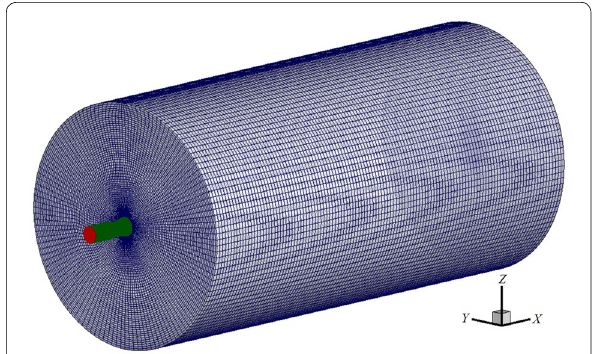
Figure 7 Velocity contour of gas jet from a single